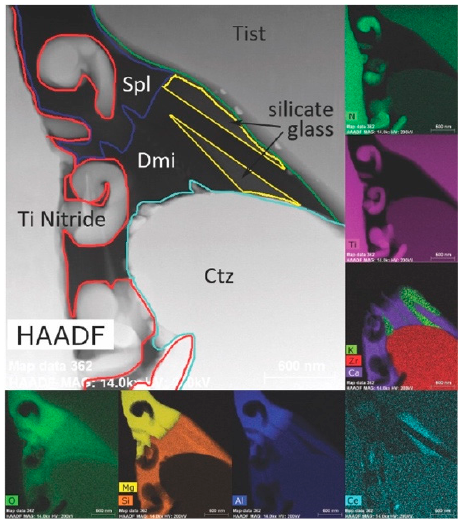
Figure 8. TEM image and element maps of contact between Ti nitride and a silicate melt pocket containing carmeltazite (Ctz) and quench crystals of dmisteinbergite (Dmi; anorthite polymorph) in silicate glass. Spl, spinel.